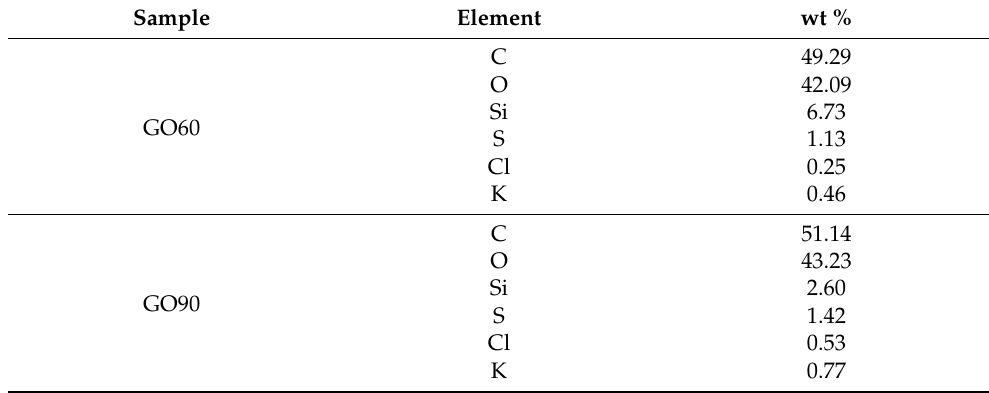
Table 4. Elemental